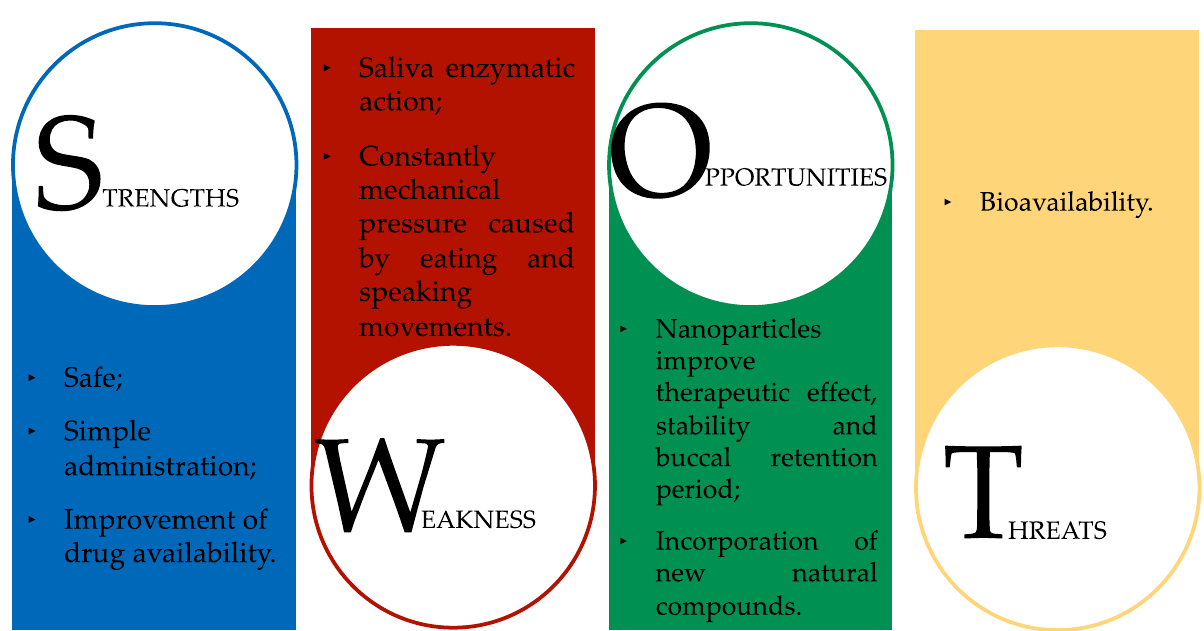
Figure 2. SWOT analysis for the possible use of natural products to prevent/treat OM.